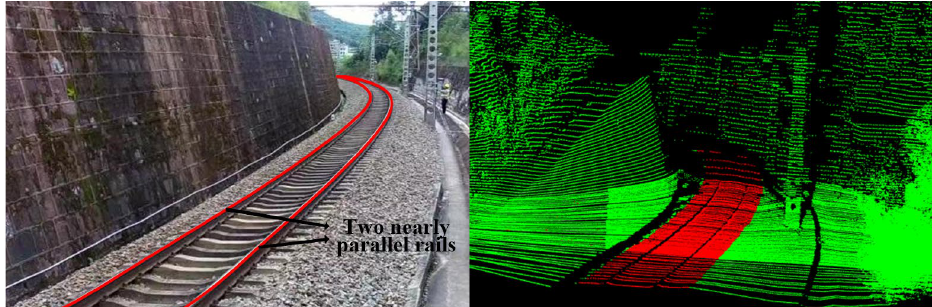
Figure 5. Segment the ROI by rail position.